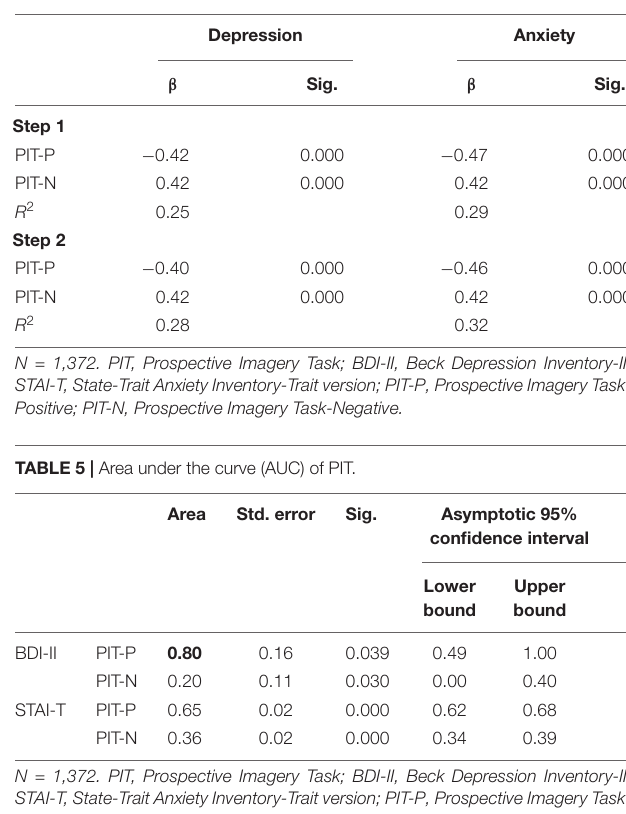
TABLE 2 | Factor loadings extracted by factor analysis with oblique rotation.